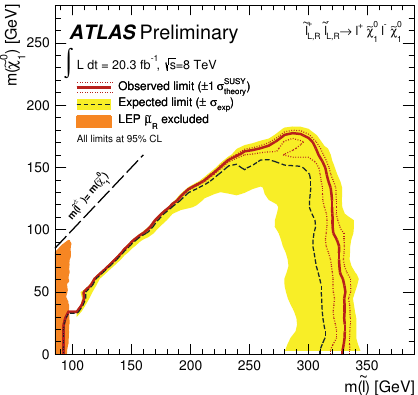
+ ˜ χ + 1 1 = m = ( m + ˜ ν ˜ χ + 1 (cid:9)